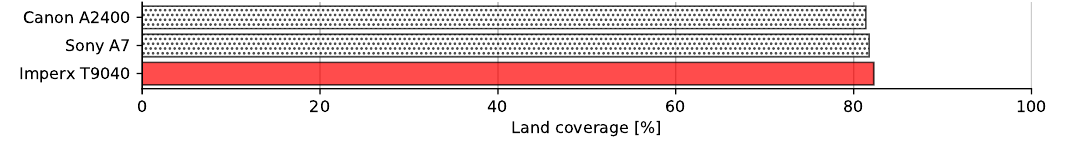
Figure 6. Land coverage of the entirety of Europe by individual cameras.